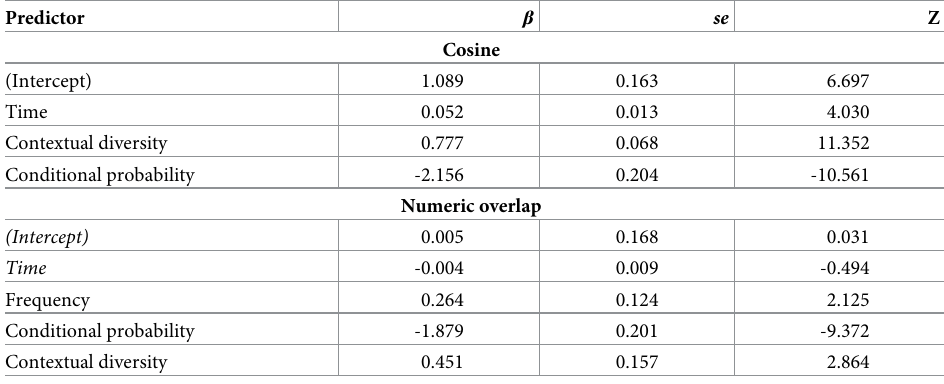
Table 6. Logistic mixed-effect models including all predictors (escluding function words). Predictor β se